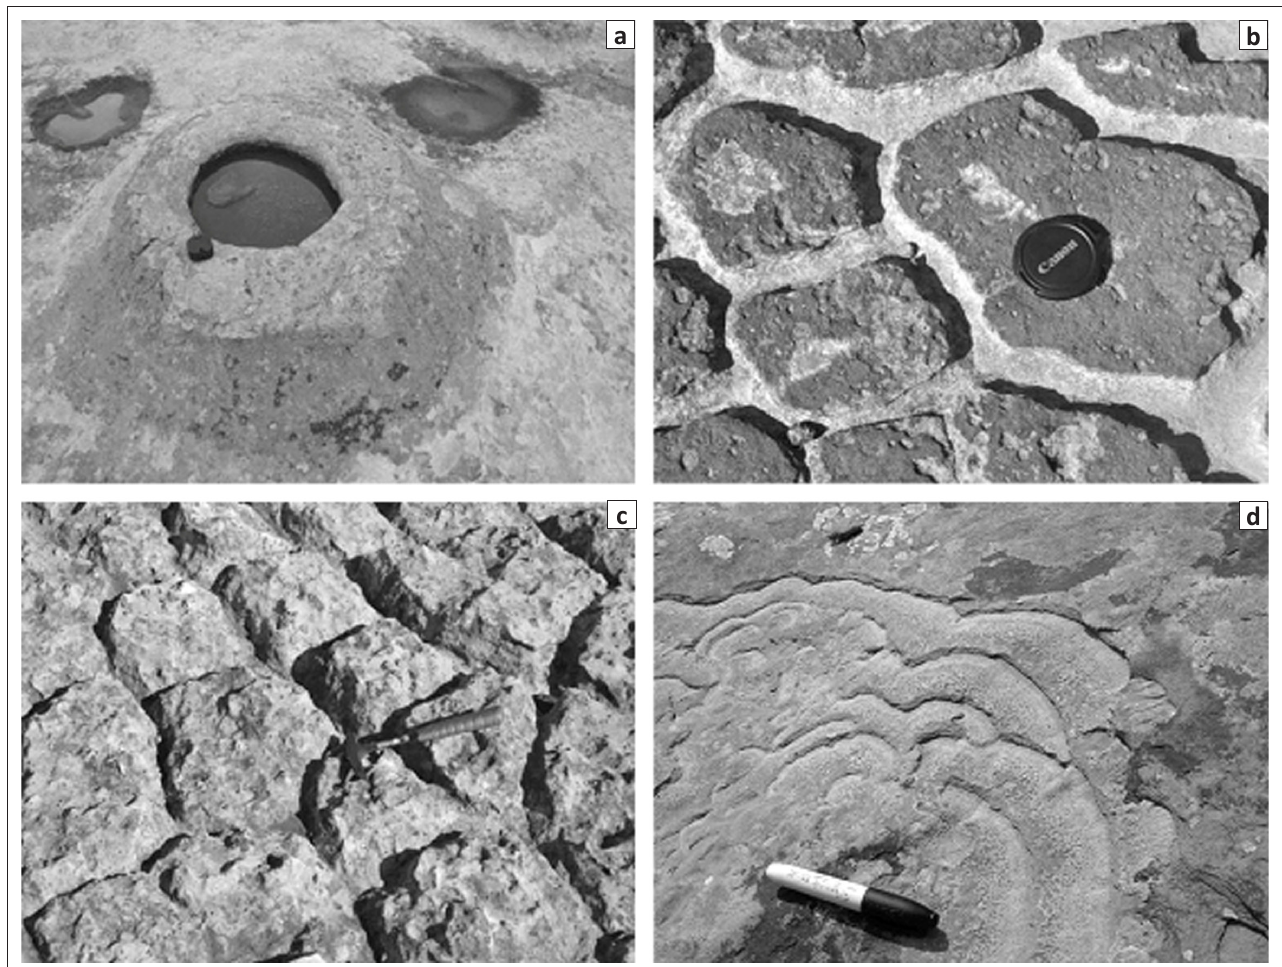
FIGURE 5: (a) A rock doughnut, (b) polygonal ‘boxwork’ structures, (c) convex polygonal structures and (d) lichen etching into Clarens Formation sandstone in the Golden Gate Highlands National